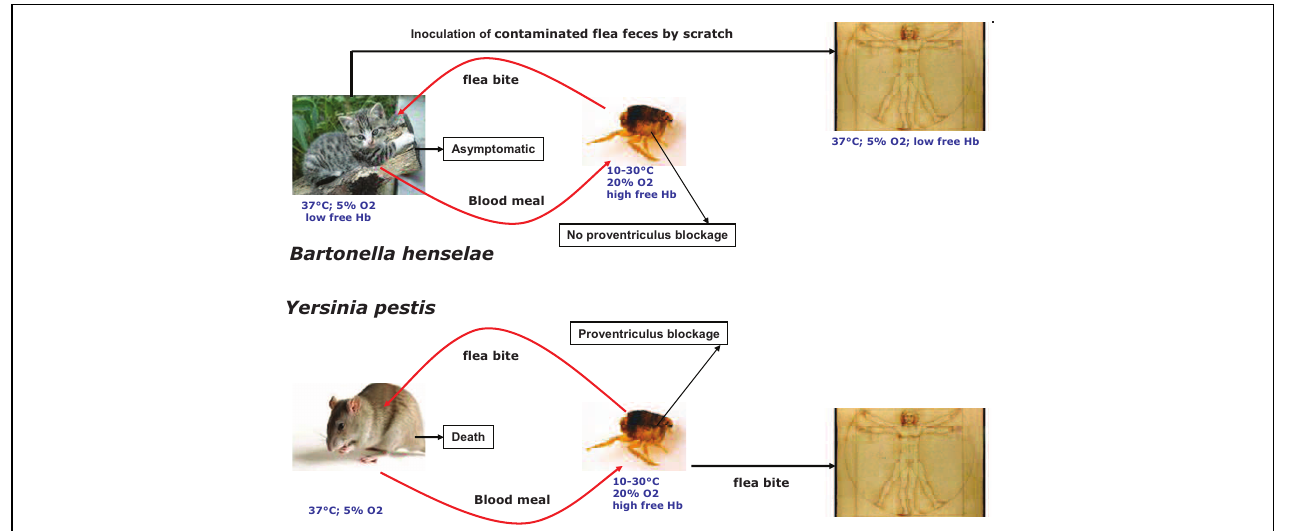
FIGURE 1 | Comparison of Bartonella henselae and Yersinia pestis transmission modes.